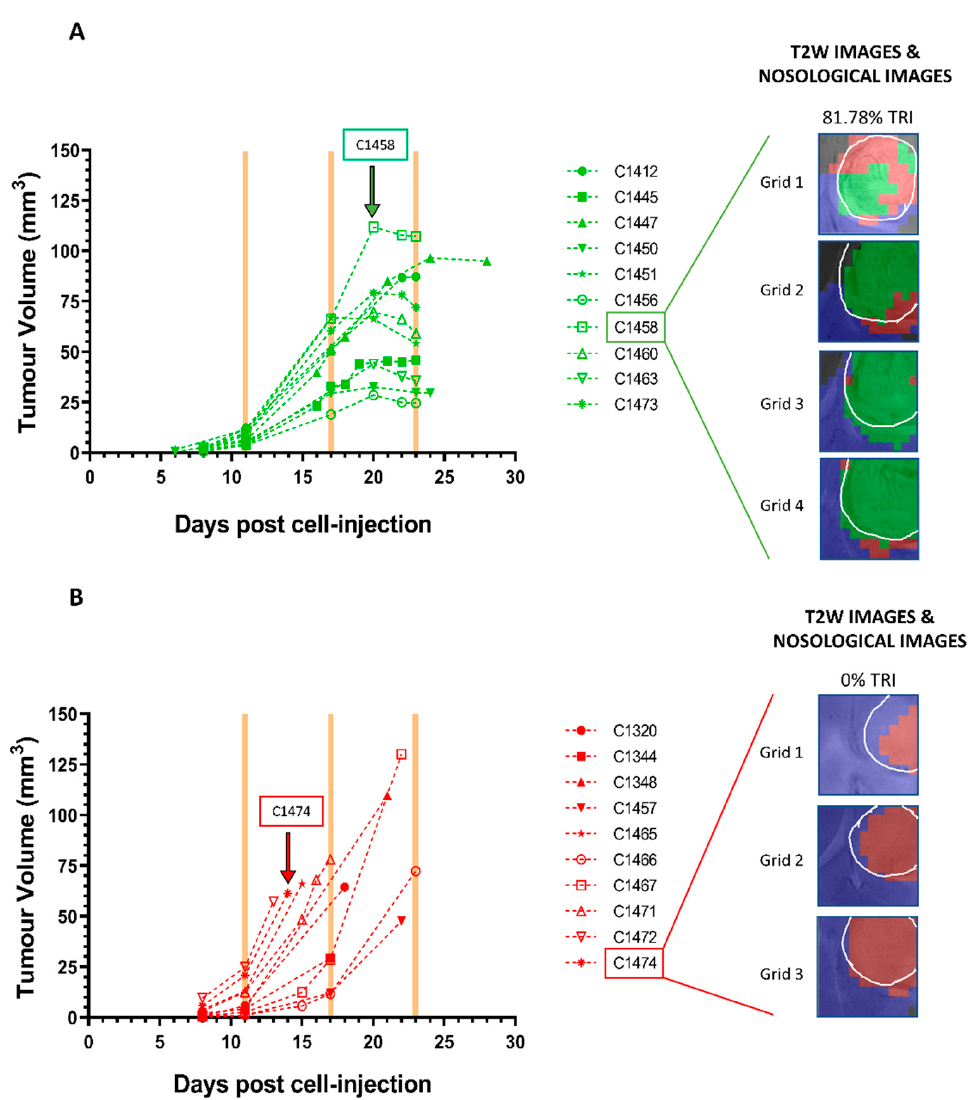
Figure 1. Tumour volume evolution (in mm 3 ) of ( A ) responding TMZ-treated ( n = 10) and ( B ) vehicle-treated ( n = 10) cases. In all responding cases, tumour volumes were in growth arrest, while in all control cases, tumour volume increased fast. Yellow shaded columns indicate TMZ administration days. The last point in the tumour volume evolution line designates the euthanasia day. The tumour volume at therapy start (day 11 p.i.) was 7.50 ± 3.22 mm 3 for TMZ-treated mice and 9.07 ± 8.44 mm 3 for control mice. At the endpoint, the tumour volume was 58.64 ± 26.43 mm 3 and the TRI was 76.97 ± 11.22% for TMZ-treated mice, while the tumour volume was 71.61 ± 29.18 mm 3 and TRI was 4.59 ± 6.31% for control mice. C1458 (unique GABRMN mice identifier) is shown as an example of a responding TMZ-treated mouse, and C1474 is shown as an example of a control mouse. Nosological images obtained from Grids 1–4 of case C1458 and Grids 1–3 of case C1474 were superimposed to the T2w-MRI. The tumour areas from the nosological images have been manually drawn over the tumour (shown in white line), and TRI was calculated from it. Rectangles over arrows at left indicate the cases and time points at which the MRSI-derived nosological images shown at right were acquired.